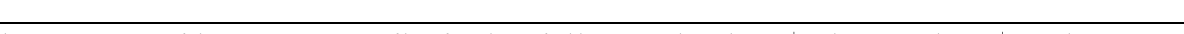
Fig. 5 A comparison of the gene expression pro fi les of single-puri fi ed human CB-derived CD34 + and CD34 − and CD90 + HSCs by qRT-PCR. Multi-plex (79 genes) single-cell qRT-PCR using CD34 + and CD34 − HSCs and CD90 + HSCs was performed. a The 54 gene expression pro fi les in CD34 + and CD34 − HSCs and CD90 + HSC are depicted using a heatmap. These 54 genes were classi fi ed as HSC/HPC-, erythrocyte-, megakaryocyte-, myeloid cell-, lymphocyte- and epigenetics-related genes. b The expression of individual genes in CD34 + and CD34 − HSCs and CD90 + HSCs is depicted by violin plots. The HSC maintenance genes highly expressed in both CD34 + and CD34 − HSCs and CD90 + HSCs ( KIT , RUNK1 , TAL1 , BMI1 , DNMT3A , TGFBR1 and R2 ) are shown in the upper panel and highlighted by green color in a . The genes highly expressed in CD34 + HSCs ( IFITM1 , MPL , IKZF1 , ETV6 , ALDH1A1 and IGF1R ) are shown in the middle left panel and highlighted by pink color in a . The genes highly expressed in CD34 − HSCs ( EZH2 and MYB ) are shown in the middle right panel and highlighted by blue color in a . The gate names (R6 and R8) presented in this fi gure correspond to the same fractions in Fig. 1e, f. c Violin plots of the reference genes, including ACTB , GAPDH , PTPRC (CD45) and PGK-1 (left). Violin plots of the genes for CD34 and PROM1 (CD133) (middle). qRT-PCR of the VNN2 (GPI-80) mRNA expression in the 18Lin − CD34 + CD38 − CD133 + GPI-80 + / − and 18Lin − CD34 − CD133 + GPI-80 + / − cells, compared with the positive control (CB-derived neutrophils) and negative control (THP-1 cells) (right). n.d.: not